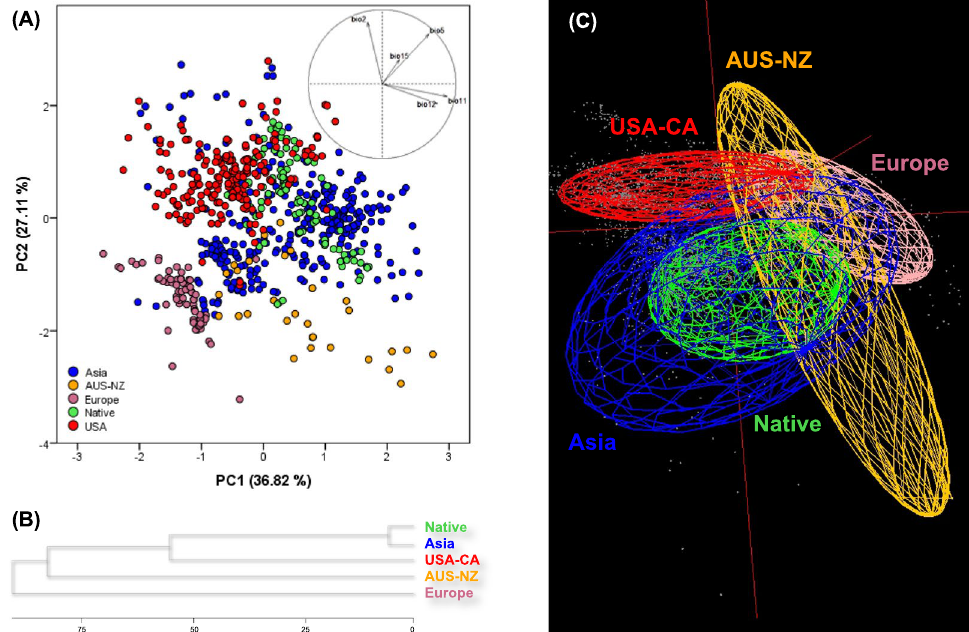
Figure 4. ( A ) Standard Principal Component Analysis (PCA) performed with climatic values of Lilium lancifolium for the occurrences of the native, archaeophyte (ASIA), and neophyte (USA-CA, AUS-NZ, and EUR) ranges. ( B ) UPGMA clustering representation derived from the coordinates of occurrences on the first three axes of the standard PCA. ( C ) Minimum-volume ellipsoids (MVE) of different regions into the environmental space performed with NicheA.